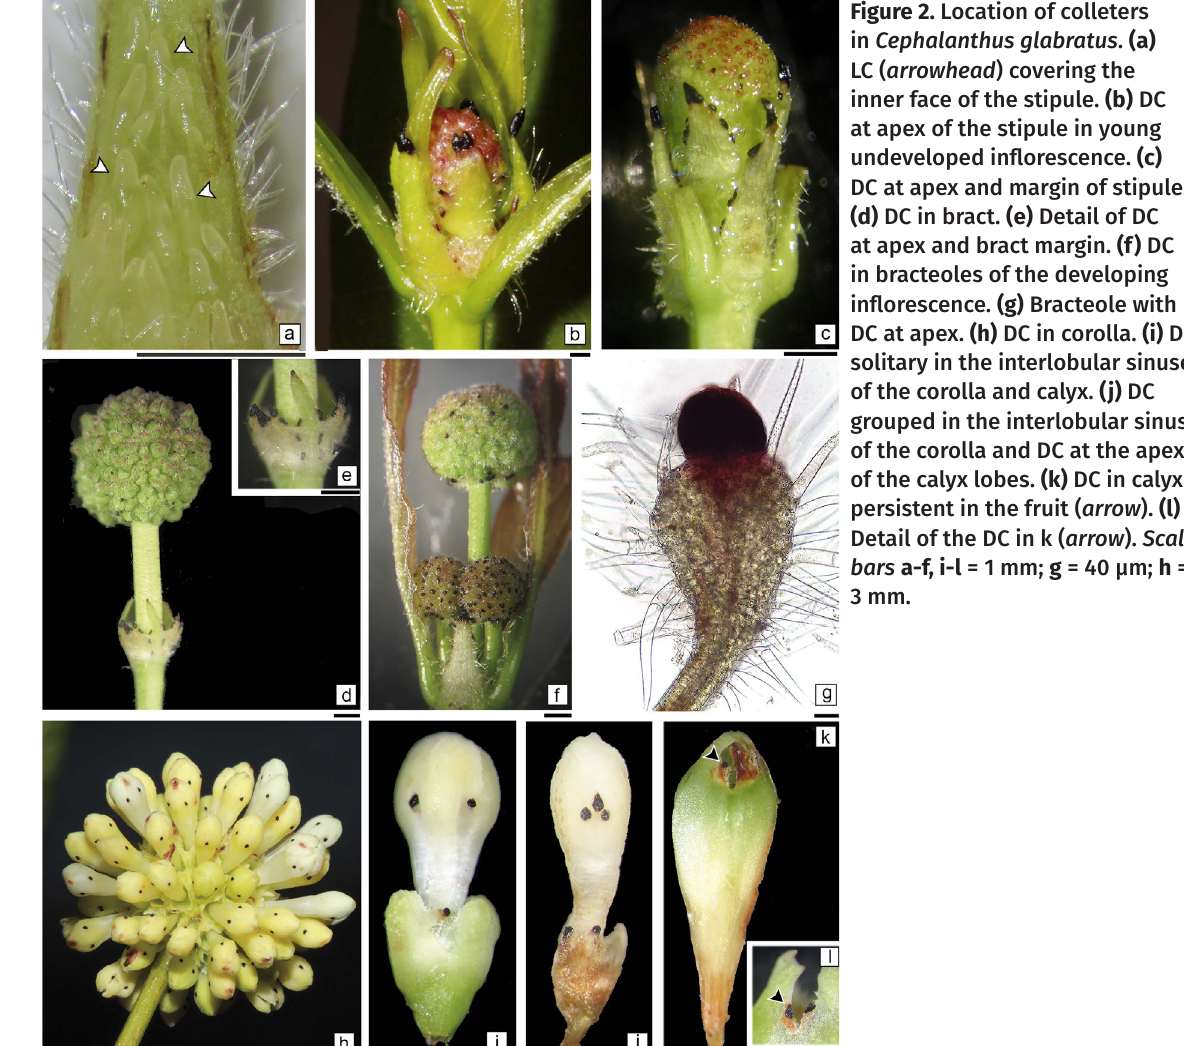
Figure 2. Location of colleters in Cephalanthus glabratus . (a) LC ( arrowhead ) covering the inner face of the stipule. (b) DC at apex of the stipule in young undeveloped inflorescence. (c) DC at apex and margin of stipule. (d) DC in bract. (e) Detail of DC at apex and bract margin. (f) DC in bracteoles of the developing inflorescence. (g) Bracteole with DC at apex. (h) DC in corolla. (i) DC solitary in the interlobular sinuses of the corolla and calyx. (j) DC grouped in the interlobular sinus of the corolla and DC at the apex of the calyx lobes. (k) DC in calyx persistent in the fruit ( arrow ). (l) Detail of the DC in k ( arrow ). Scale bars a-f, i-l = 1 mm; g = 40 µm; h = 3